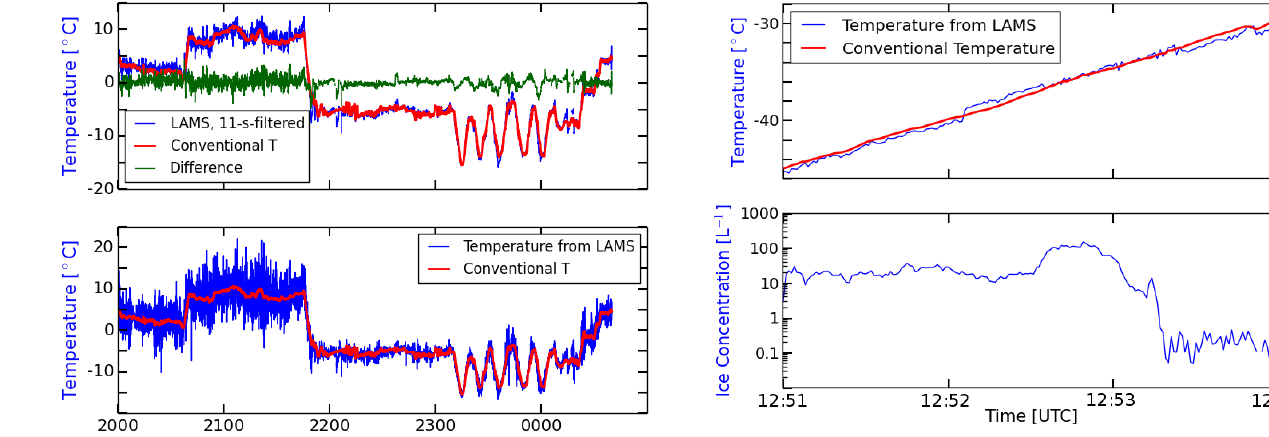
Figure 9. Top panel: temperature determined from LAMS measure- ments of airspeed using Eq. (24) compared to the temperature mea- sured by a conventional immersion temperature sensor during a de- scent through a cirrus cloud layer. Bottom panel: the measured ice concentration from a two-dimensional cloud (2-DC) imaging